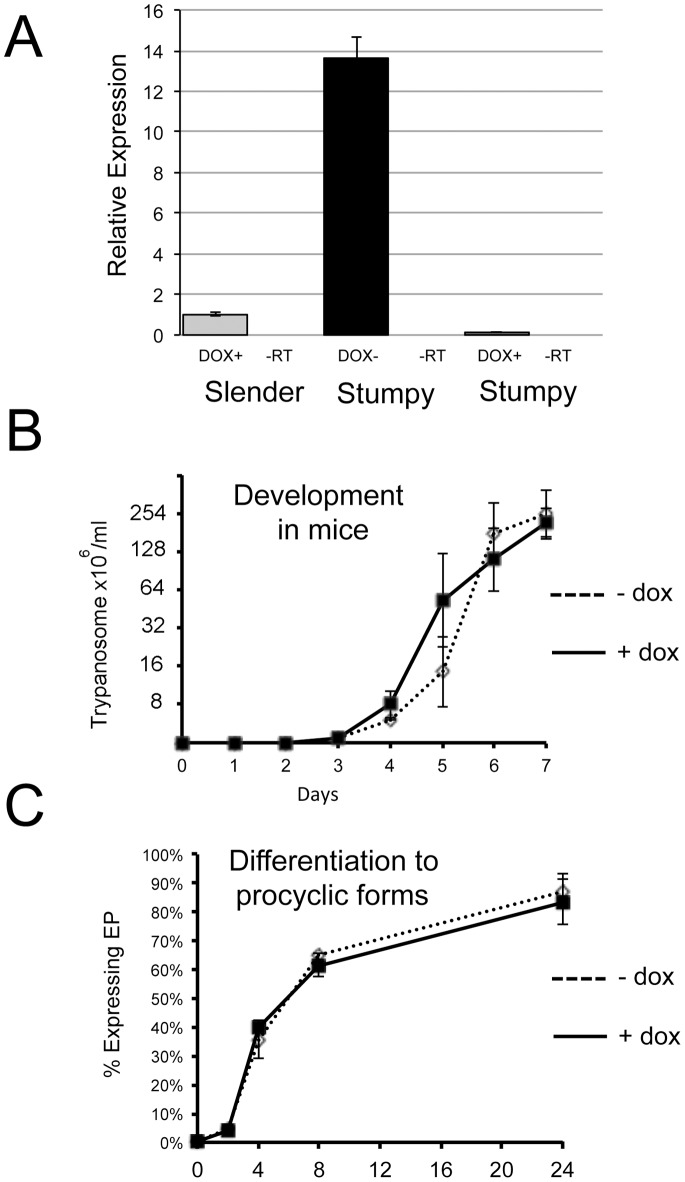
RNA interference against Tb927.7.3150 does not perturb differentiation in vivo.A. Realtime qRT PCR analysis of the expression and RNAi mediated knockdown of Tb927.7.3150 mRNA in pleomorphic T. brucei AnTat1.1 90:13 cells. Samples were derived from rodent infections with RNAi being induced by doxycycline provided in the drinking water. RNAi induction generated depletion of the Tb927.7.3150 transcripts to levels below that detected in slender forms. B. Progression of the course of parasitaemia of Tb927.7.3150 RNAi lines induced (solid lines), or not (dashed lines), to deplete the target transcript. No difference in the progression of the parasitaemia was observed whether RNAi was induced or not. n = 3. C. Tb927.7.3150 parasites either induced (solid lines), or not (dashed lines), were harvested from rodent infections once predominantly stumpy in morphology (on day 7 post infection for both induced and uninduced samples). Their differentiation to procyclic forms was then monitored by the expression of EP procyclin. In both cases the expression of this differentiation marker was equivalent regardless of the knockdown of Tb927.7.3150 mRNA levels.